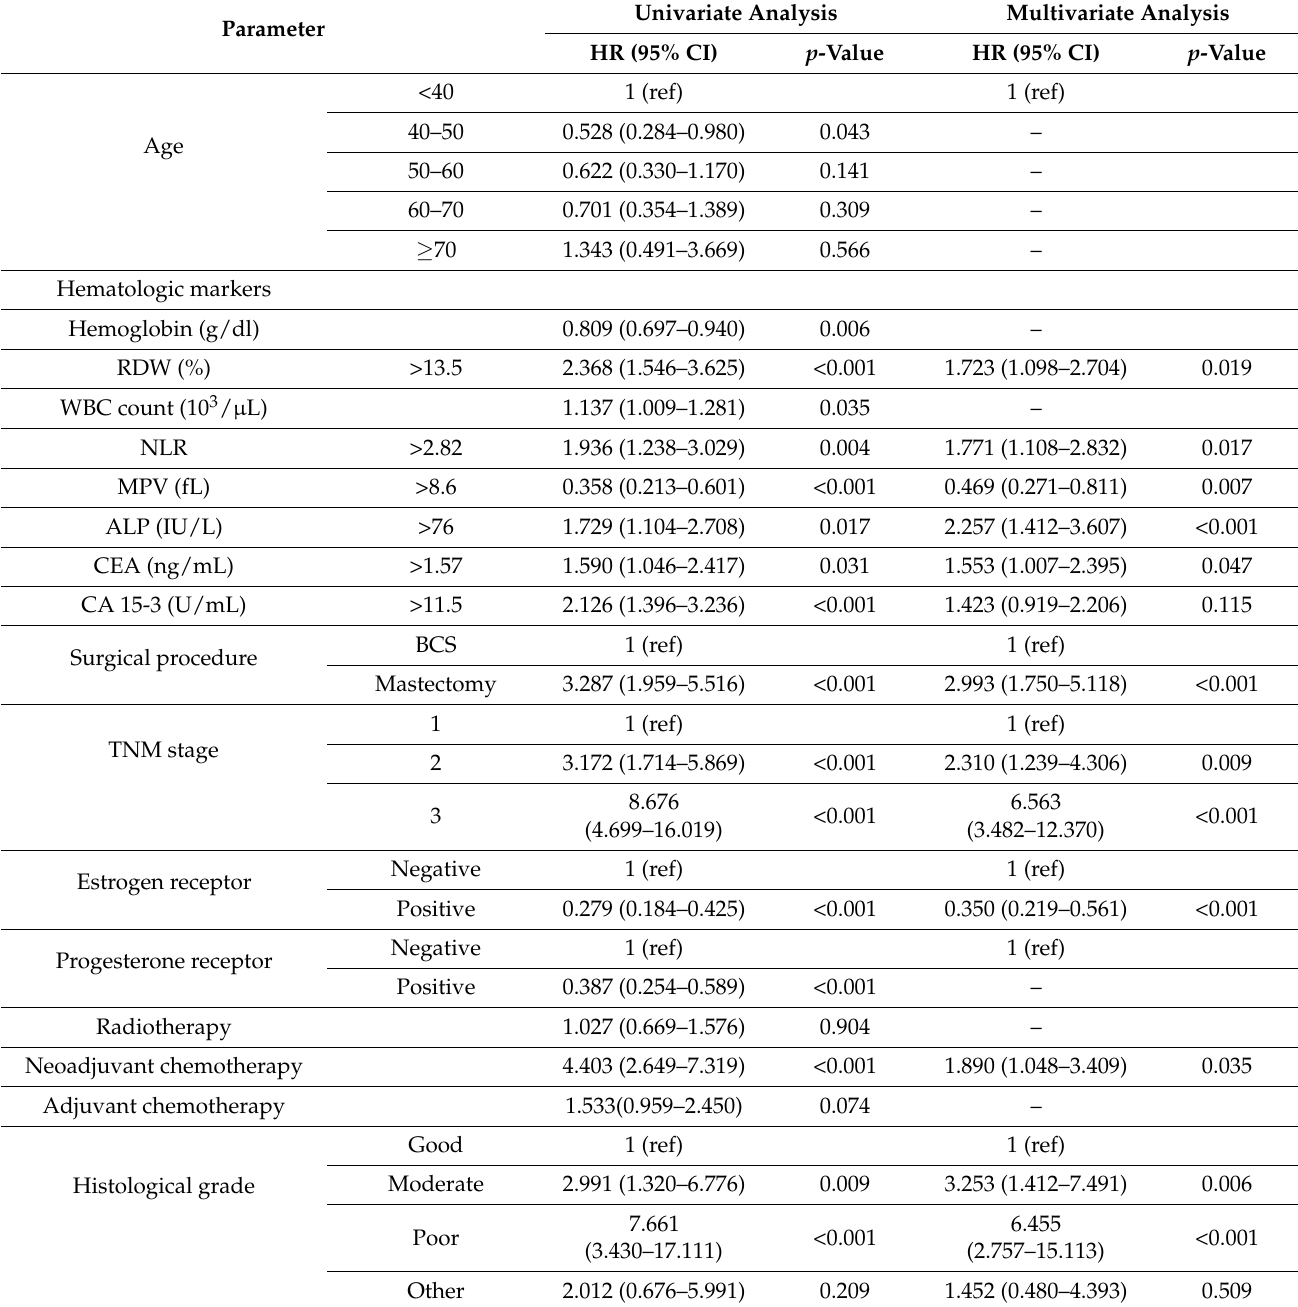
Table 4. Independent risk factors for patients with breast cancer associated with postoperative mortality after Cox regression analysis with 1 to 5 propensity score